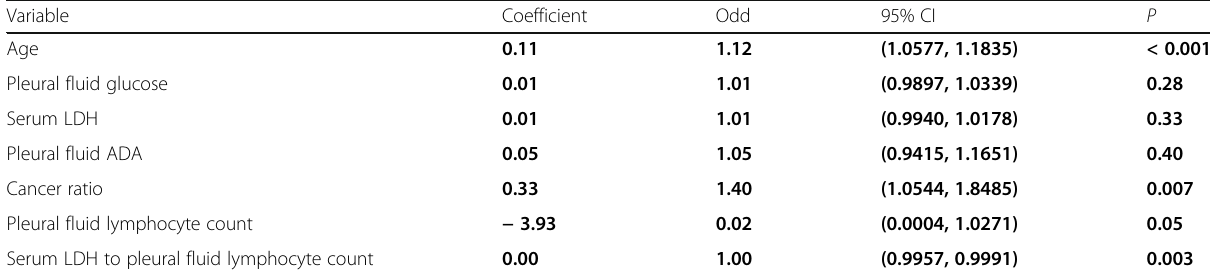
Table 3 Multivariate analysis of predictors used in malignancy Variable